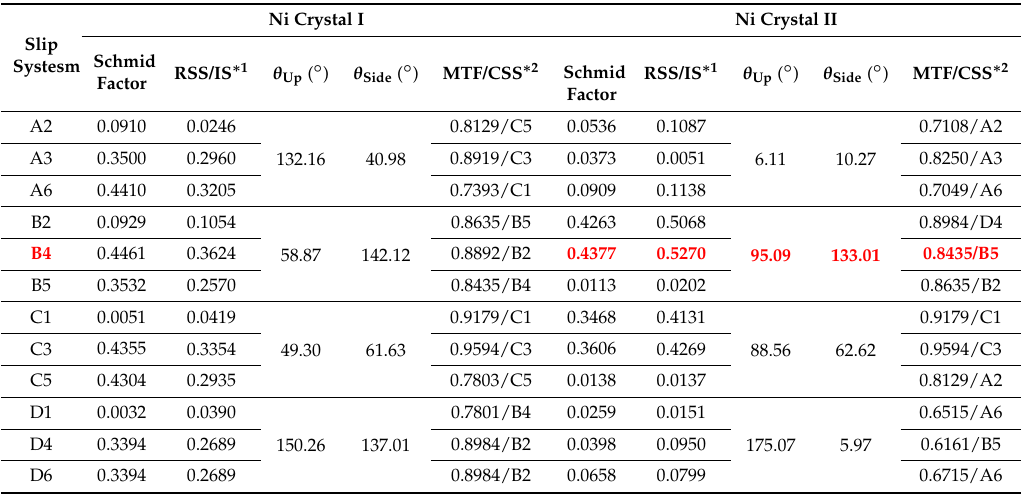
∗ 1 RSS: Resolved shear stress normalized by the applied stress when considering elastic incompatibility stresses (IS) following the formula reported by Richeton and Berbenni [37,38,40]. ∗ 2 MTF: Maximum transmission factor based on the formula given by Shen et al. [4] with corresponding slip system (CSS) [39] in the adjacent